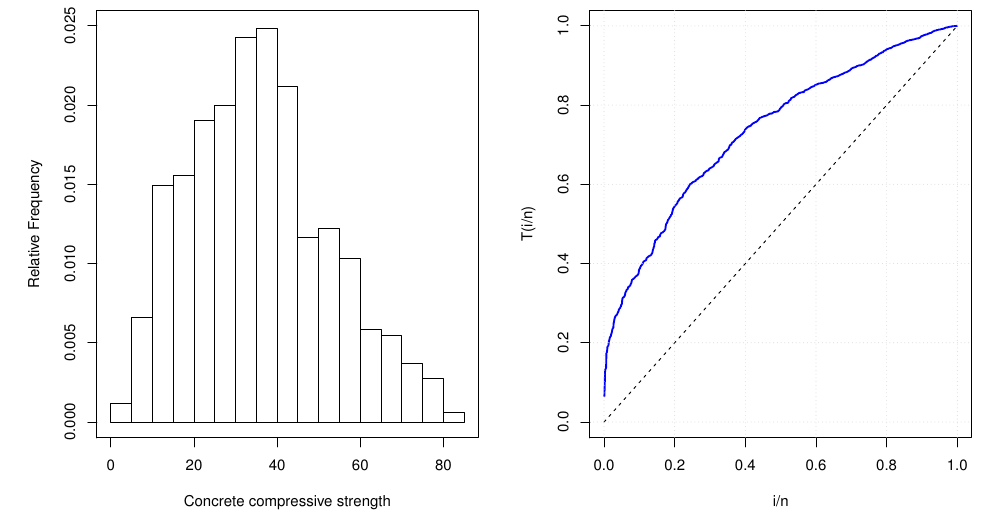
Figure 4. Histogram and TTT plots for the concrete compressive strength